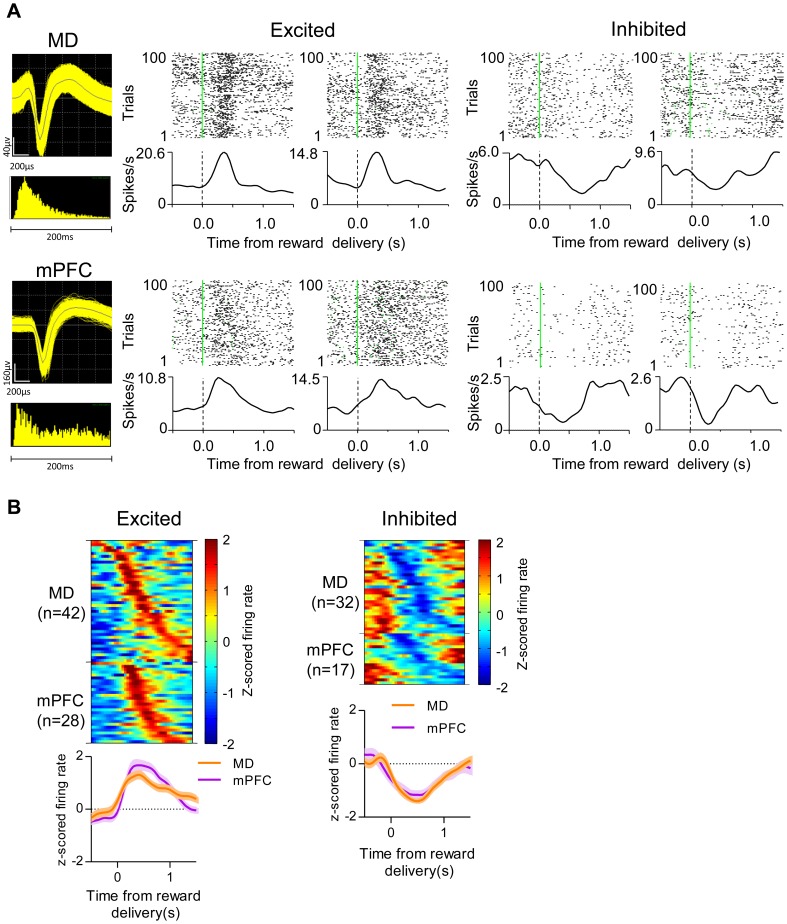
Neuronal activity in MD and mPFC during acquisition.A, Left, action potential waveform and distribution of interspike intervals of representative neurons recorded from MD and mPFC. Right, Perievent raster plots of representative neurons. Each row in raster plot represents a single trial. Green line represents time of reward delivery. Reward excited neuron increases firing after the completion of lever press action and delivery of reward. Reward inhibited neuron decreases firing upon the delivery of reward. B, Top, spike density functions of individual neurons that transiently increased (MD n = 42; mPFC n = 28) or decreased (MD n = 32; mPFC n = 17) activity following reward delivery. Each row shows a z-score normalized spike density function for a single neuron. The neurons are sorted by the latency to the maximum or minimum amplitude. Bottom, normalized population firing rate of reward excited and inhibited neurons at the time of reward delivery. Shaded areas indicate SEM.